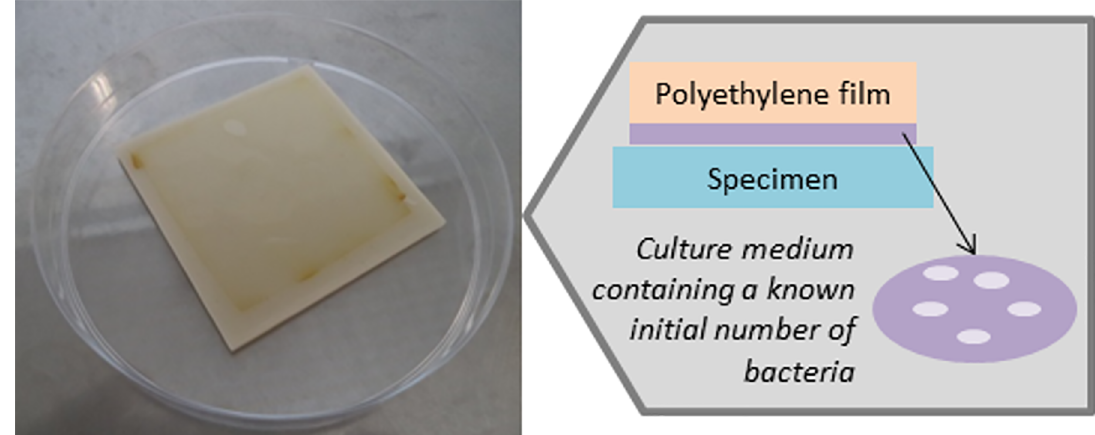
Figure 1. Representative scheme of antibacterial assay composed by TPE specimen, bacterial suspension, and the polyethylene film. Table 1. Mechanical properties of Standard sample and sample incorporated with 1.5 % of ZnPT and AgNano. Compounds